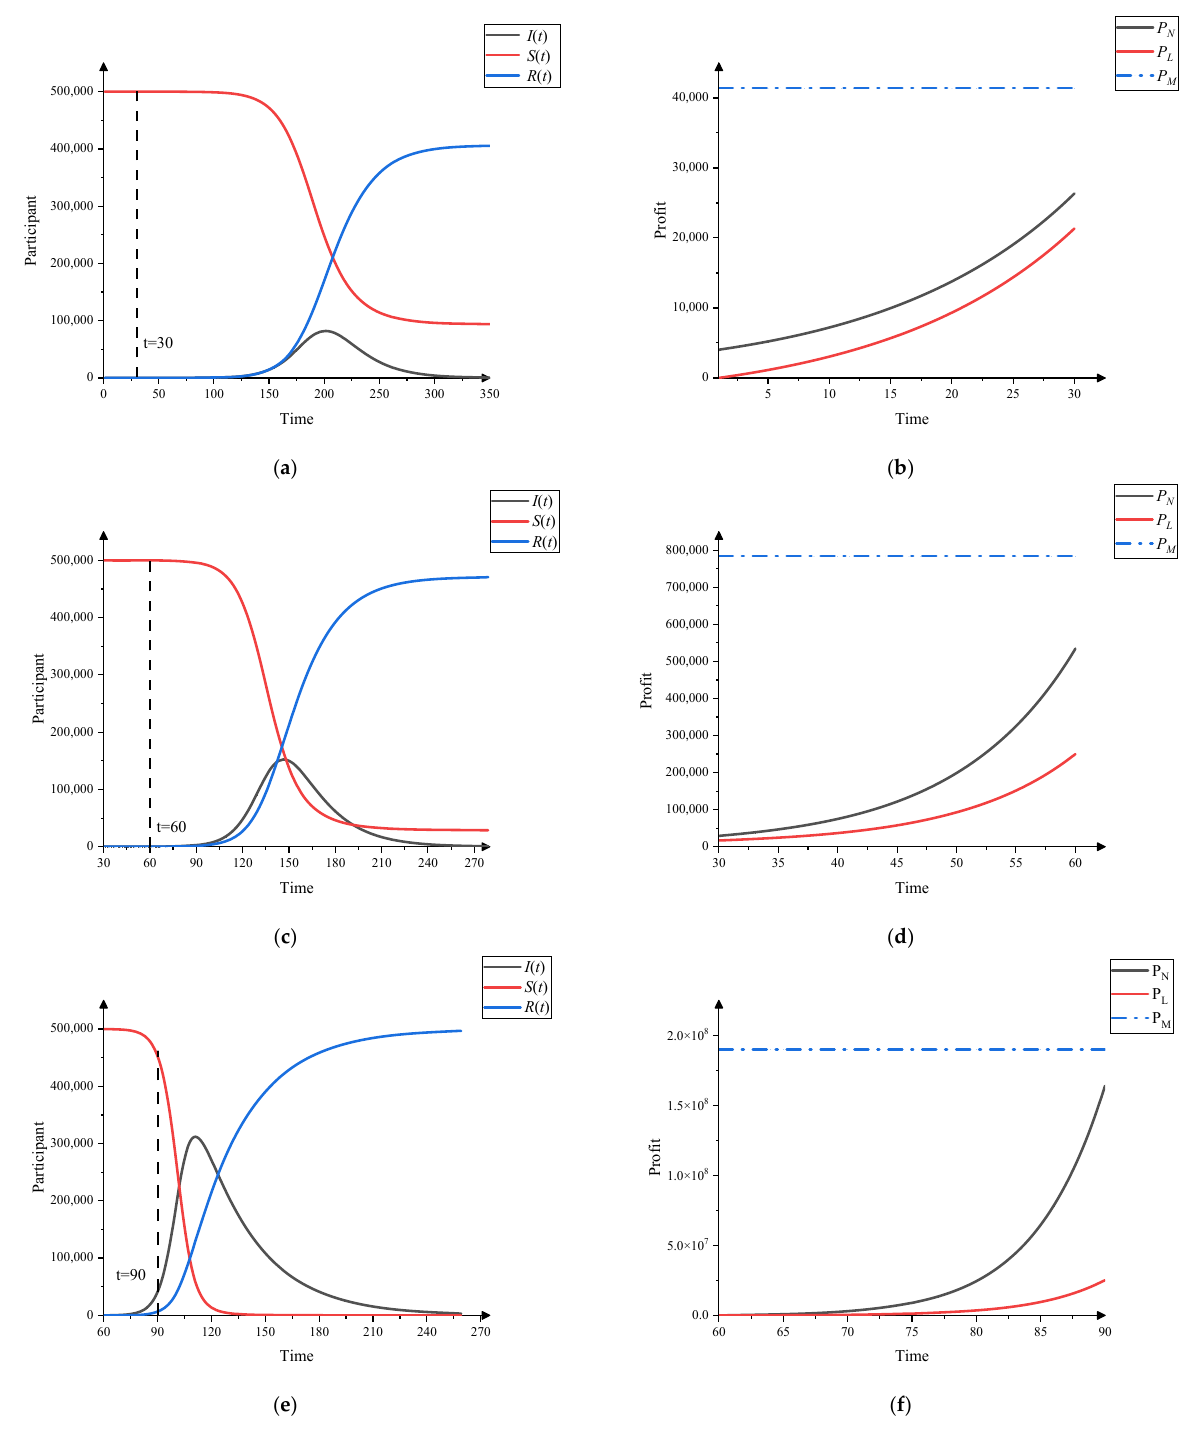
Figure 4. Fraud spread and fraud profit. ( a ) Participants in the first cycle of fraud; ( b ) Profits from the first cycle of fraud; ( c ) Participants in the second cycle of fraud; ( d ) Profits from the second cycle of fraud; ( e ) Participants in the third cycle of fraud; ( f ) Profits from the third cycle of